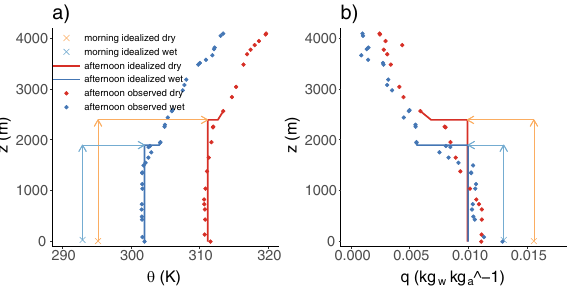
Fig. 1 Diurnal ABL evolution over wet and dry soils, respectively. Potential temperature θ ( a ; in K) and speci fi c humidity q ( b ; in kg water per kg air) versus height on characteristic dry (07-07-2012) and wet days (25-06-2014; 89.33 W, 40.15 N). The solid lines depict the idealized afternoon pro fi le to which the ABL model validated, inferred from balloon soundings in the data-screening steps (see “ Screening of weather balloon sounding measurements ” and “ Data ” in Methods) from afternoon observations (points) while crosses denote the morning ABL that the model is initialized with. Colored boxes and corresponding arrows indicate the growth of the ABL and warming/drying during the